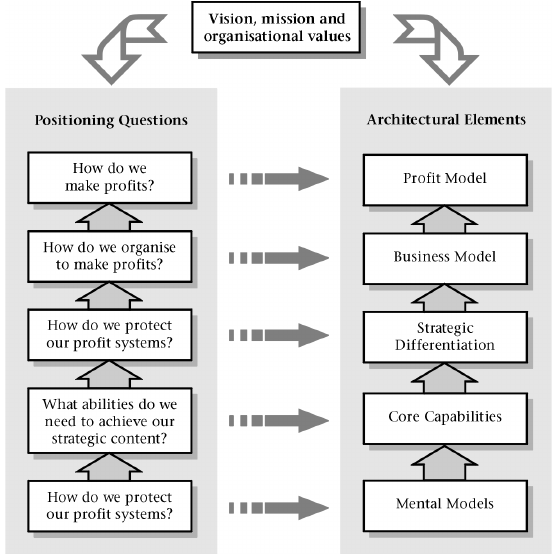
Figure 2: Core elements of a Strategic